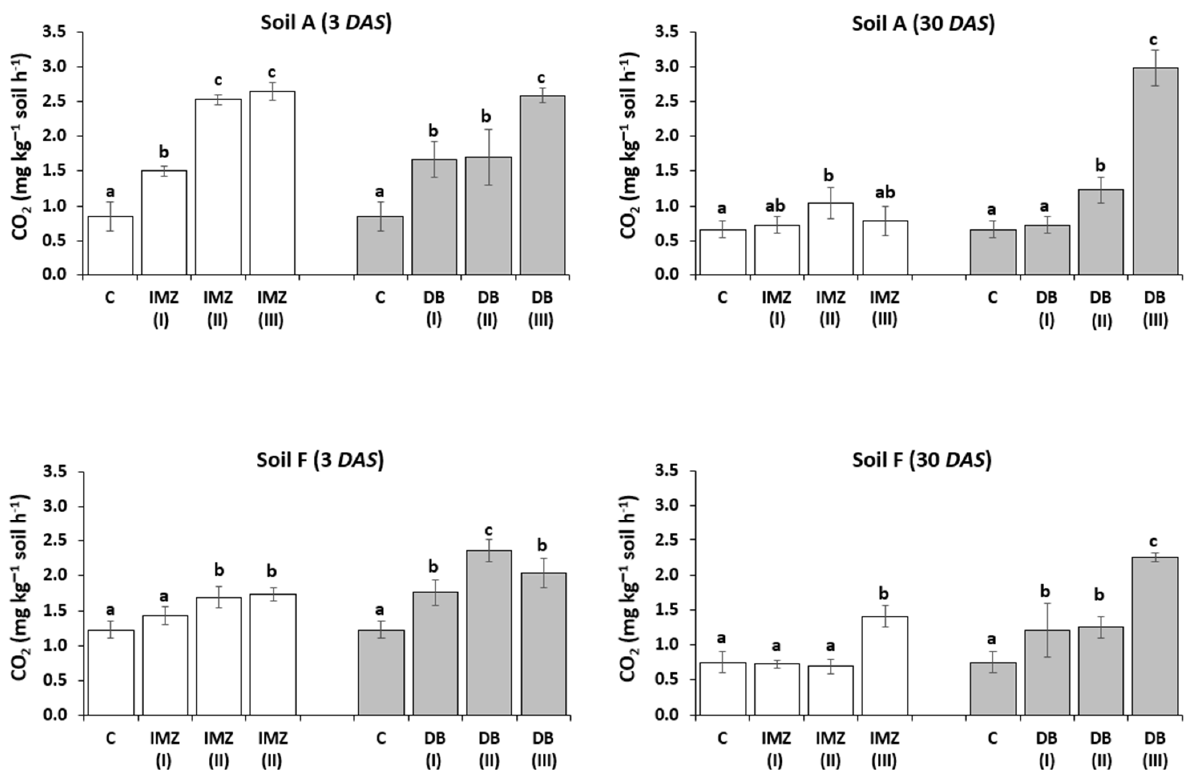
Figure 2. Influence of different concentrations of imazamox (IMZ) and 2,4-DB (DB) on soil respiration (mean values ± SE) at 3 and 30 days after herbicide spiking ( DAS ). IMZ(I), (II) and (III) refer to 3, 15, 150 µ g IMZ g − 1 soil, respectively. DB(I), (II) and (III) refer to 100, 500, 5000 µ g DB g − 1 soil, respectively. C, control (untreated) soil. For each soil and herbicide, different letters on top of bars indicate statistically significant differences (Bonferroni corrected p -value <